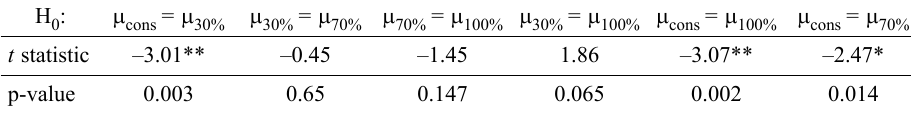
Table 8. Results of hypothesis testing across 4 fund categories